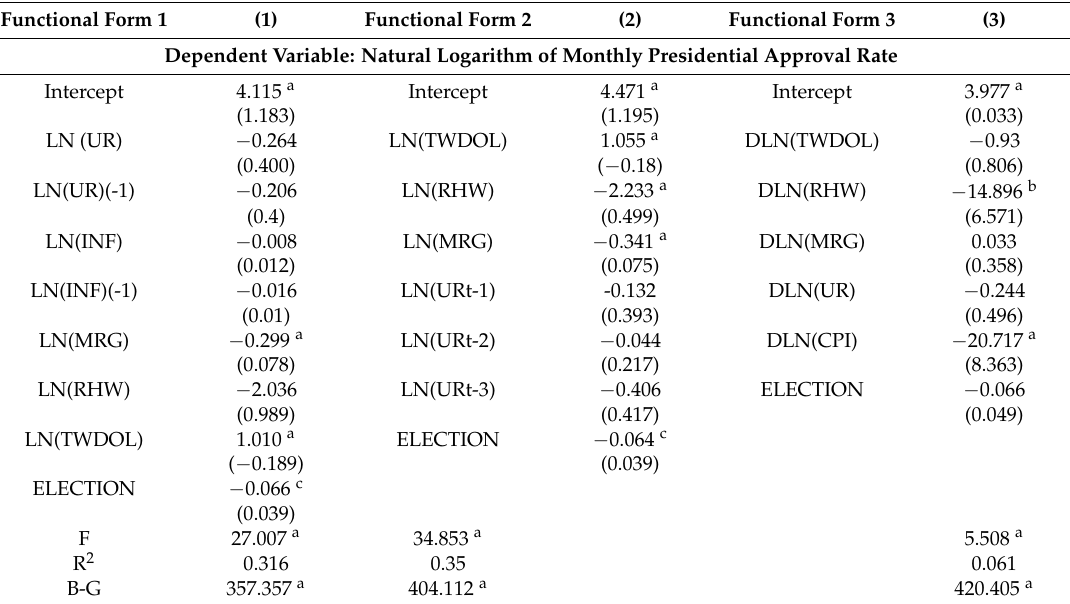
Table 1. Estimation results of alternative formulations of Equation